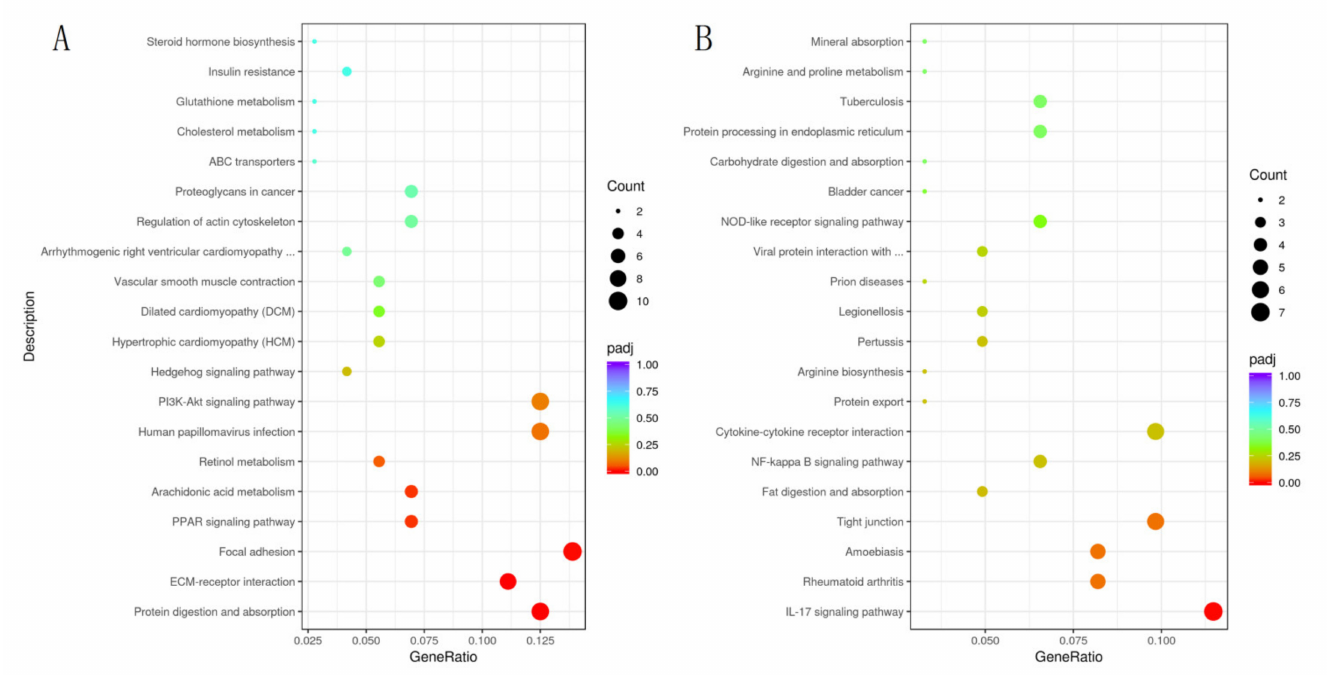
Figure 7. The most enriched KEGG pathway of the DEGs, significantly upregulated DEGs ( A ), signif- icantly downregulated DEGs ( B